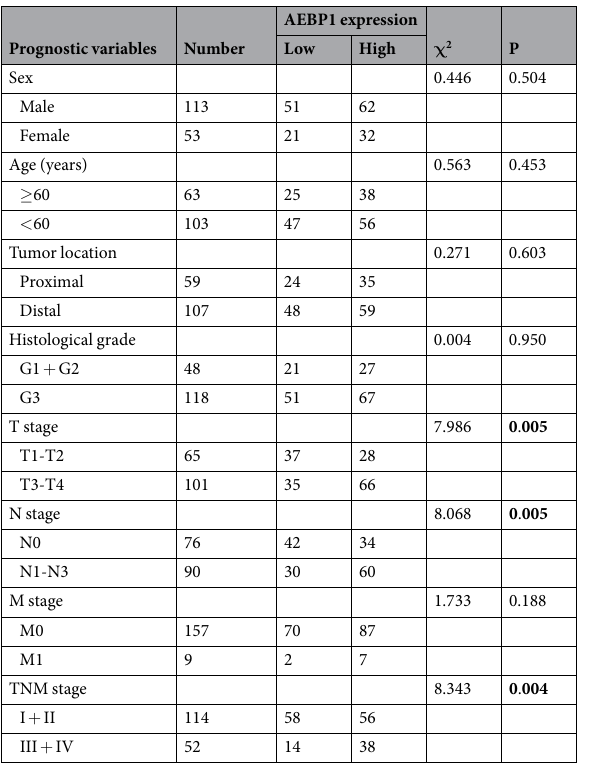
Table 1. The relationship between AEBP1 expression and clinicopathological features in patients with gastric